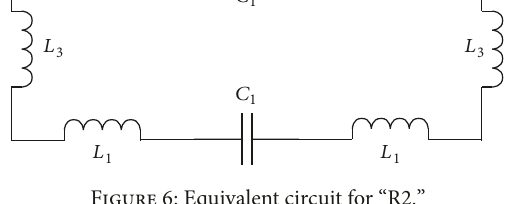
Figure 6: Equivalent circuit for “R2.”